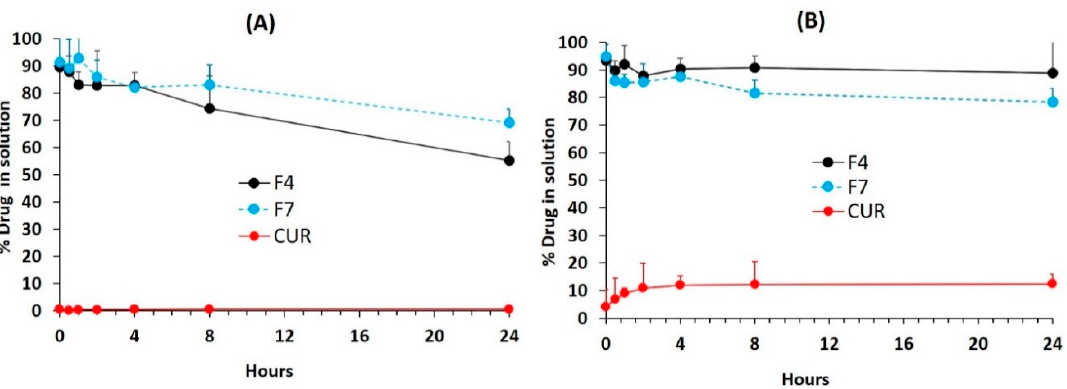
Figure 7. Percentage of the original dose of CUR remaining in solution after 1:100 dilutions of the formulations F4 Bio-SNEDDS (BSO / I988 / KolliphorEL (35 / 15 / 50 % w / w )), F7 SNEDDS (HCO-30), and CUR pure powder in ( A ) FaSSGF and ( B ) FeSSIF dispersion medium (the CUR concentration in the dose was 80% of equilibrium solubility in the anhydrous formulation). Data are presented as mean ± SD ( n = 3).